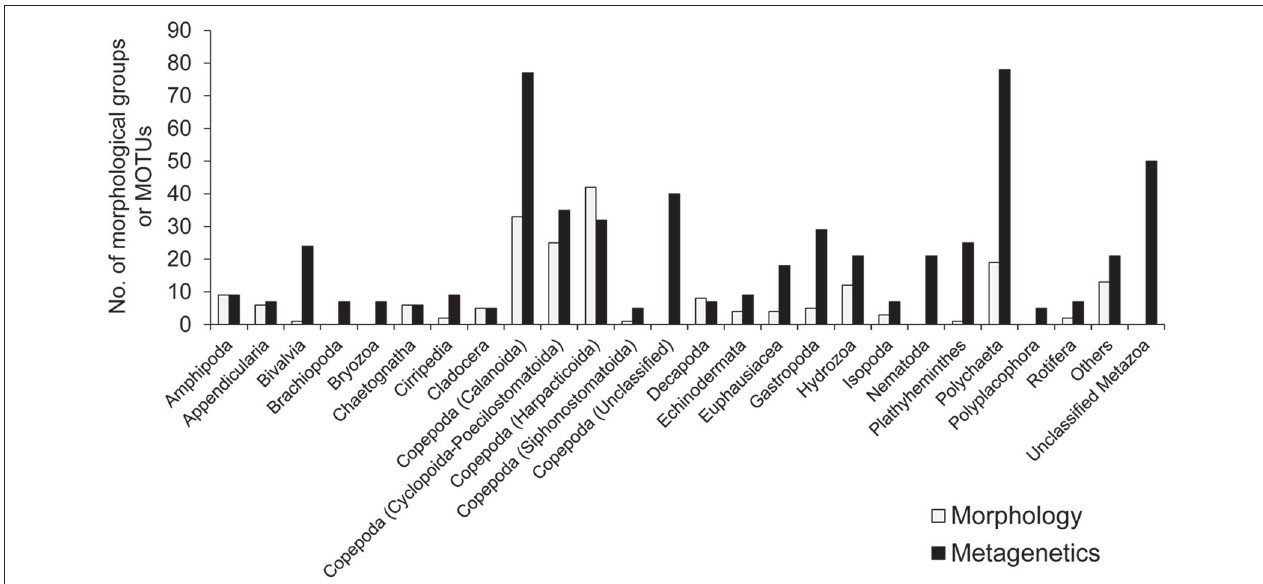
FIGURE 2 | The number of major taxonomic groups identified by morphological and metagenetic analyses. Taxa attributable to Copepoda are further classified to order. Taxonomic groups represented by fewer than five morphological groups and molecular taxonomic units (MOTUs) are grouped under “Others.” Detailed information for all taxonomic groups is shown in Table